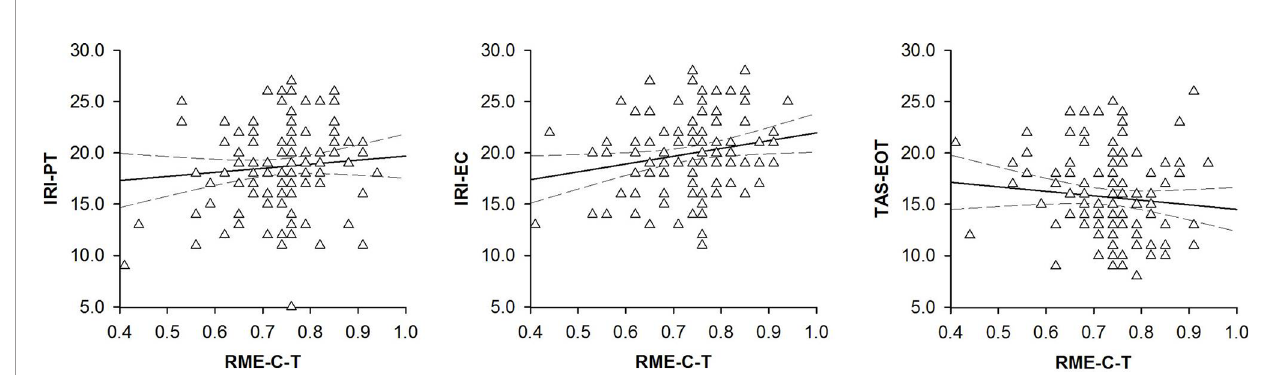
FIGURE 4 | Scatterplots with lines of best fi t demonstrating correlations between participants ’ performance on the Reading the Mind in the Eyes of Children Test [RME-C-T, (23)] and ( left panel ) participants ’ scores on the Interpersonal Reactivity Index-Perspective Taking Scale [IRI-PT, (25)], ( middle panel ), participants ’ scores on the Interpersonal Reactivity Index-Empathetic Concern Scale [IRI-EC, (25)] and ( right panel ) participants ’ scores on the Toronto Alexithymia Scale-Externally Oriented Thinking [TAS-EOT, (28, 29)].